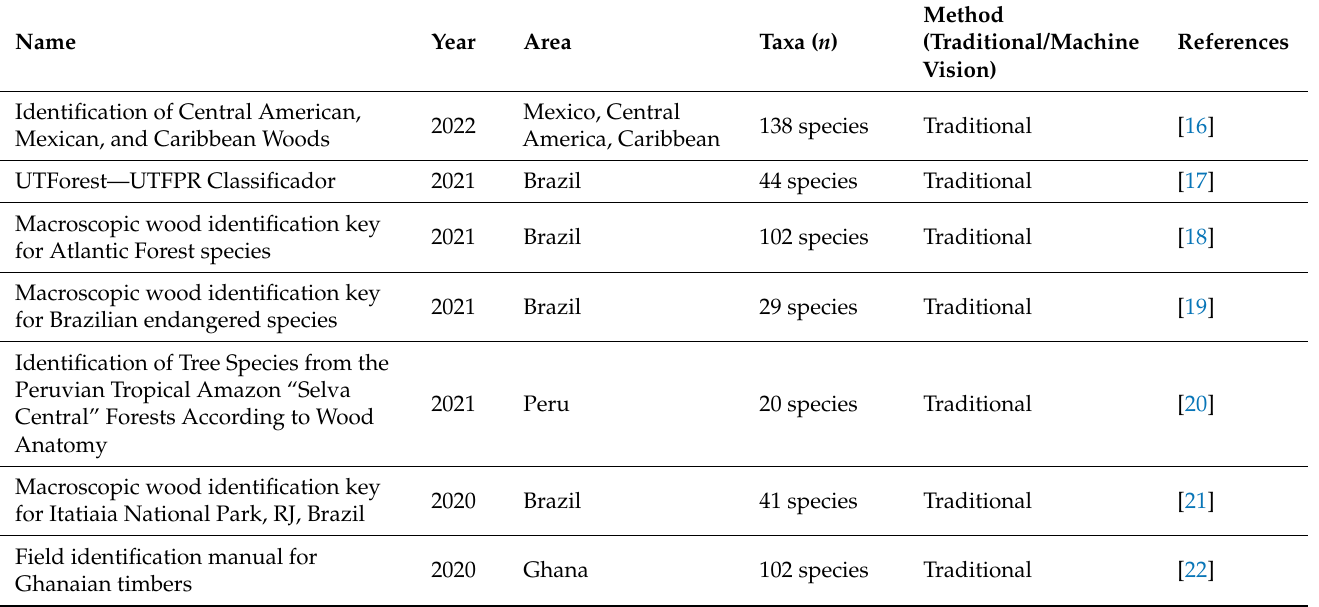
Table 2. List of recent references on macroscopic wood identification. The identification method is reported as traditional when performed by humans, and as machine vision when on an automated